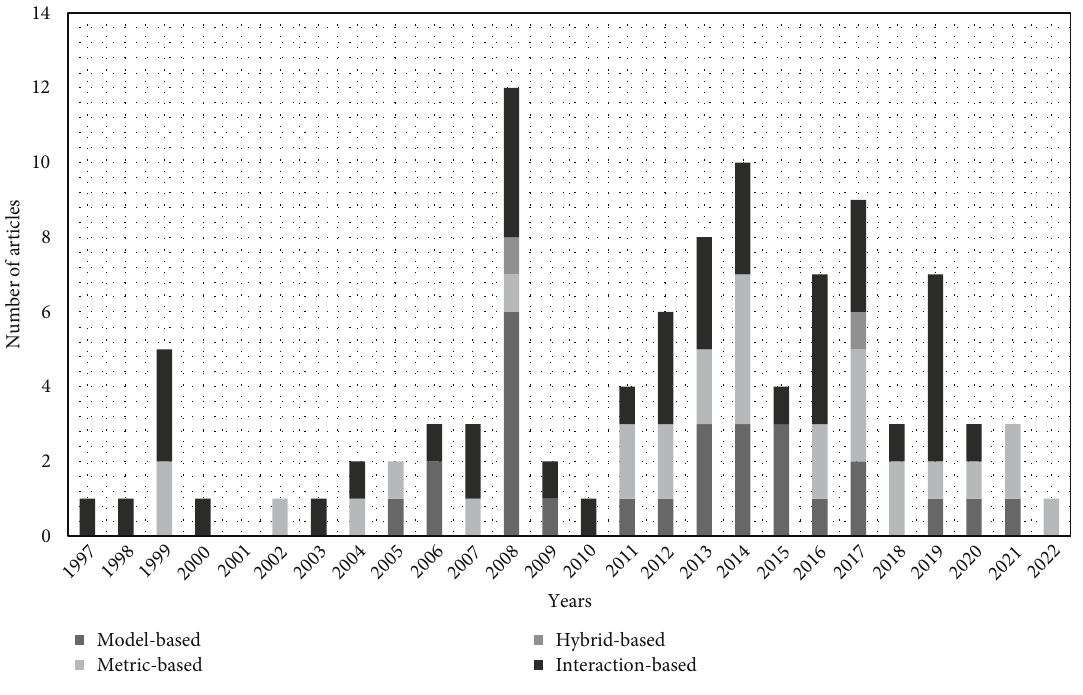
Figure 2: Evolution tendency of the heuristic solutions.